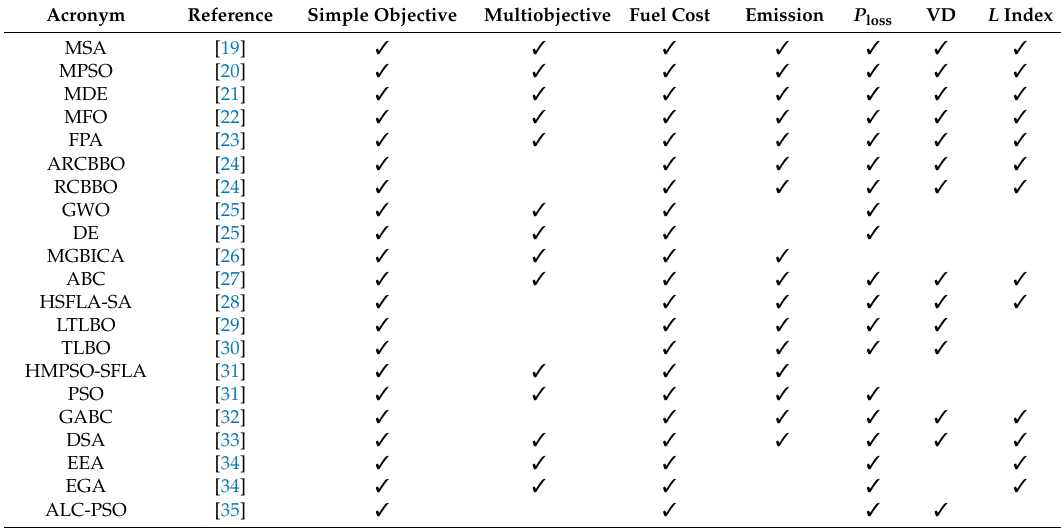
Table 3. Recently published approaches to solve OPF